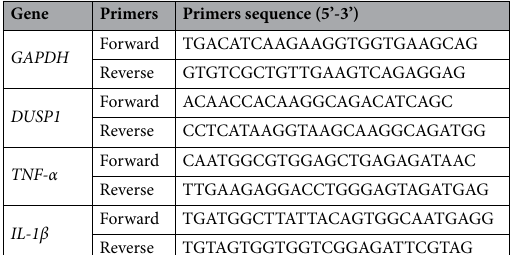
Detection of mitochondrial membrane potential (MMP) by flow cytometry.